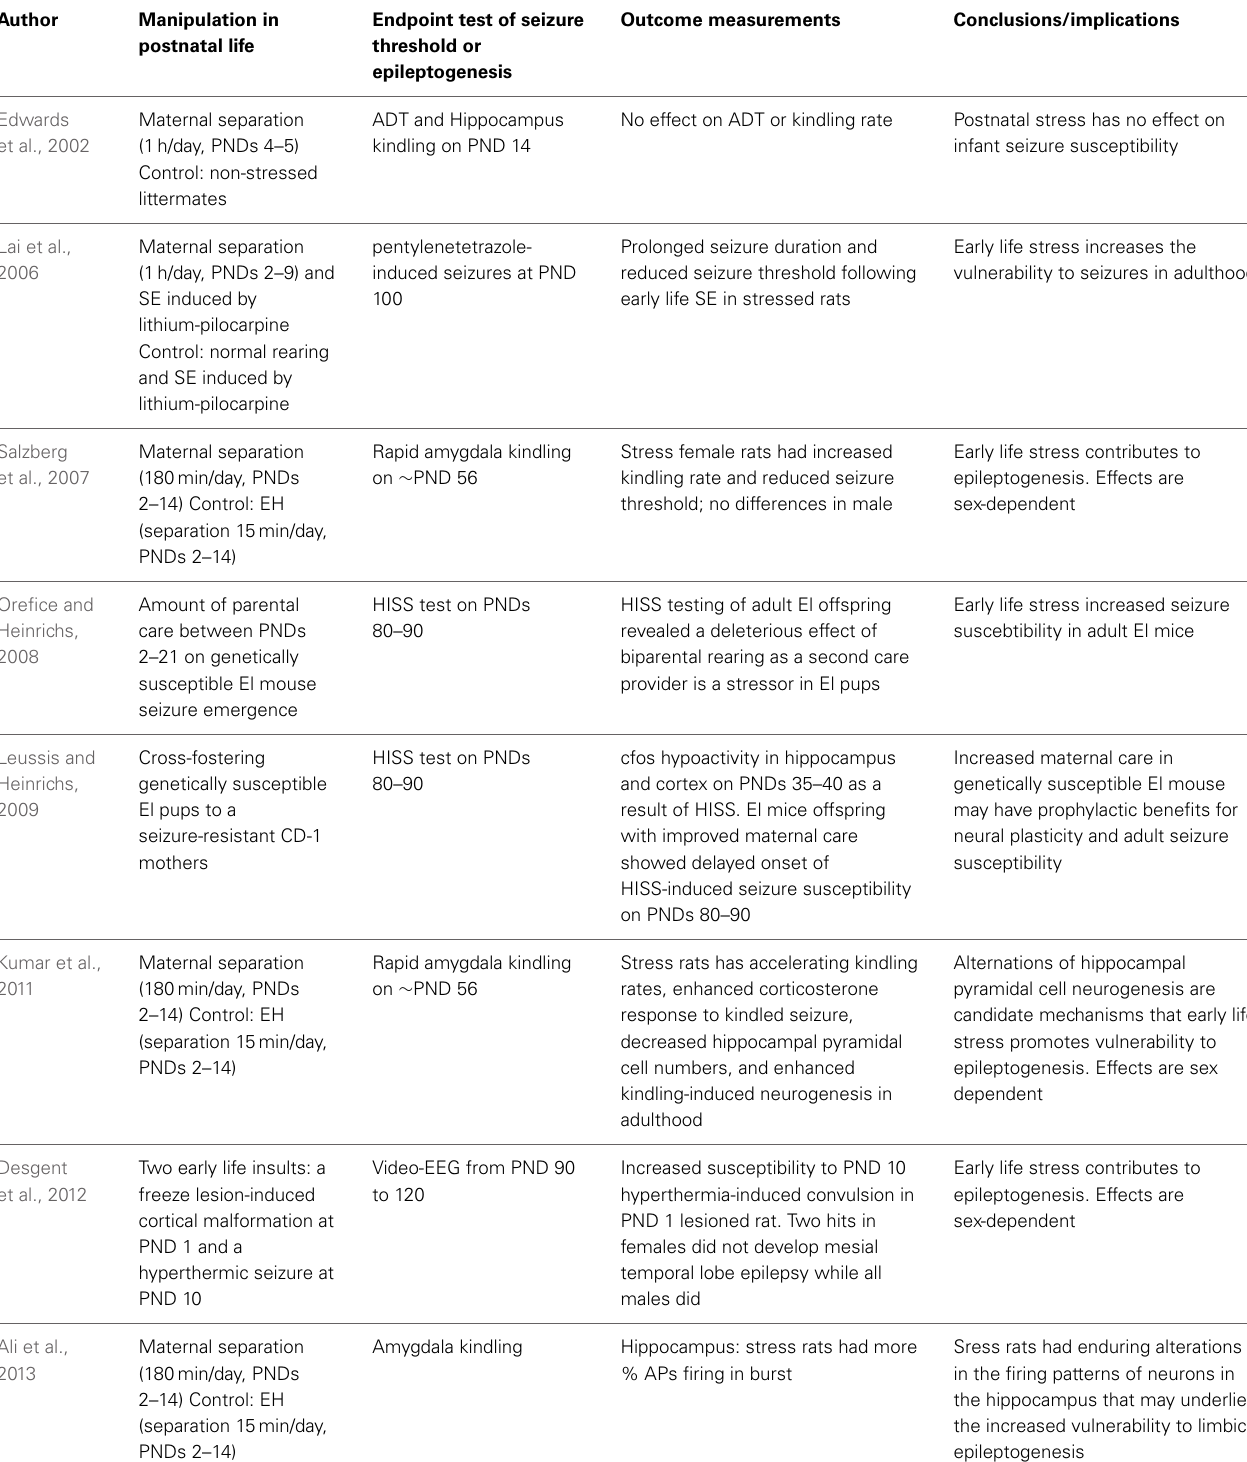
Table 2 | Summary of rodent studies investigating effects of postnatal stress in rodent models of